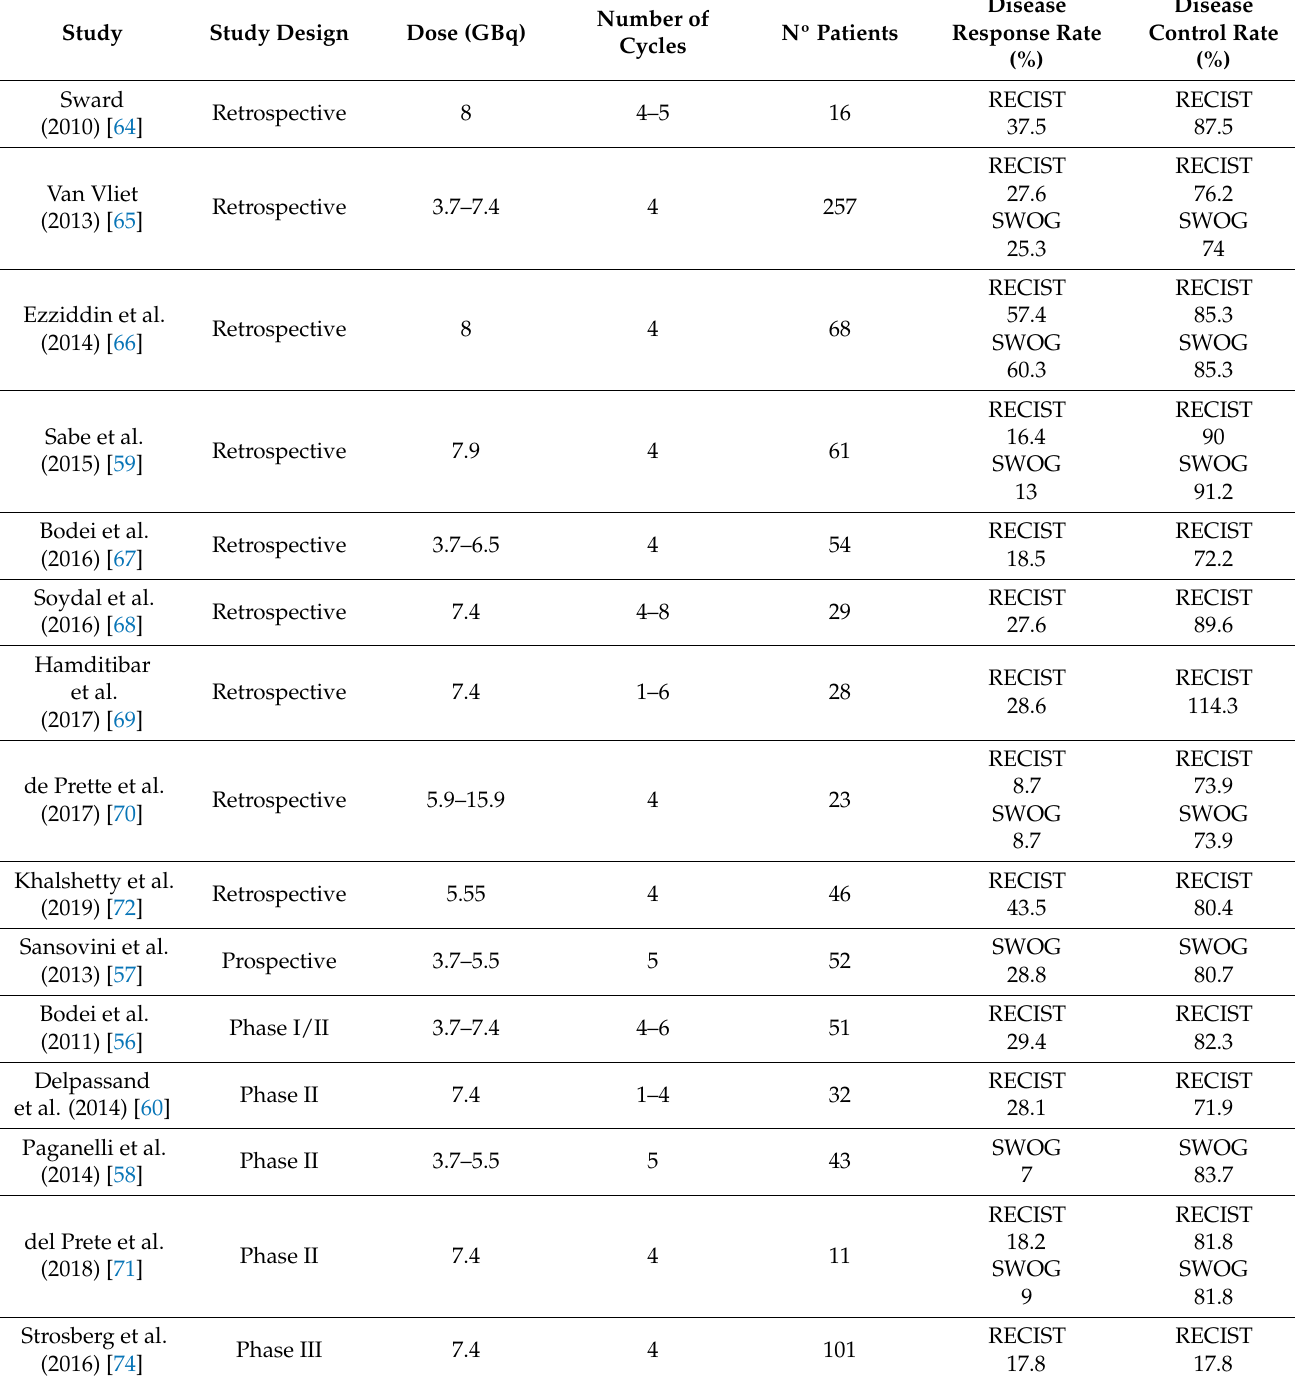
Table 3. Results comparing disease response and control rate of PRRT in